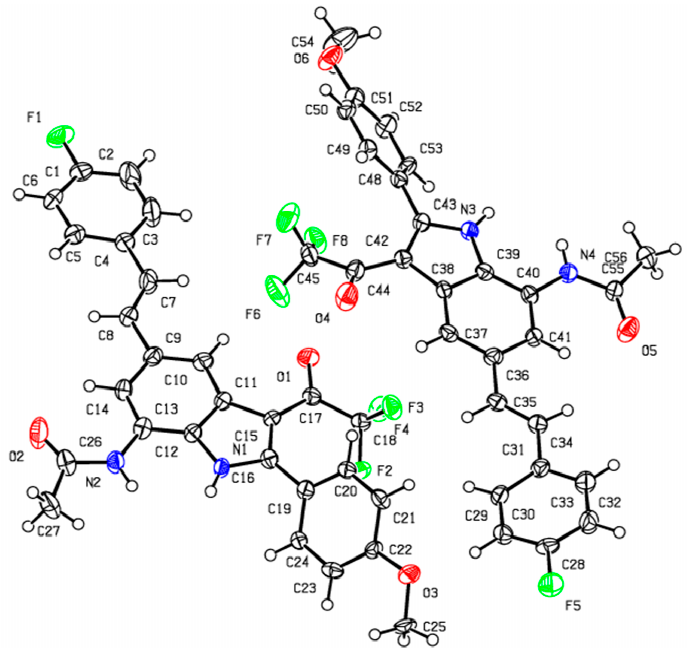
Figure 2. Oak Ridge Thermal Ellipsoid Plot (ORTEP) diagram of 4g . Displacement ellipsoids are drawn at the 50% probability level and H atoms are shown as small spheres of arbitrary radii.